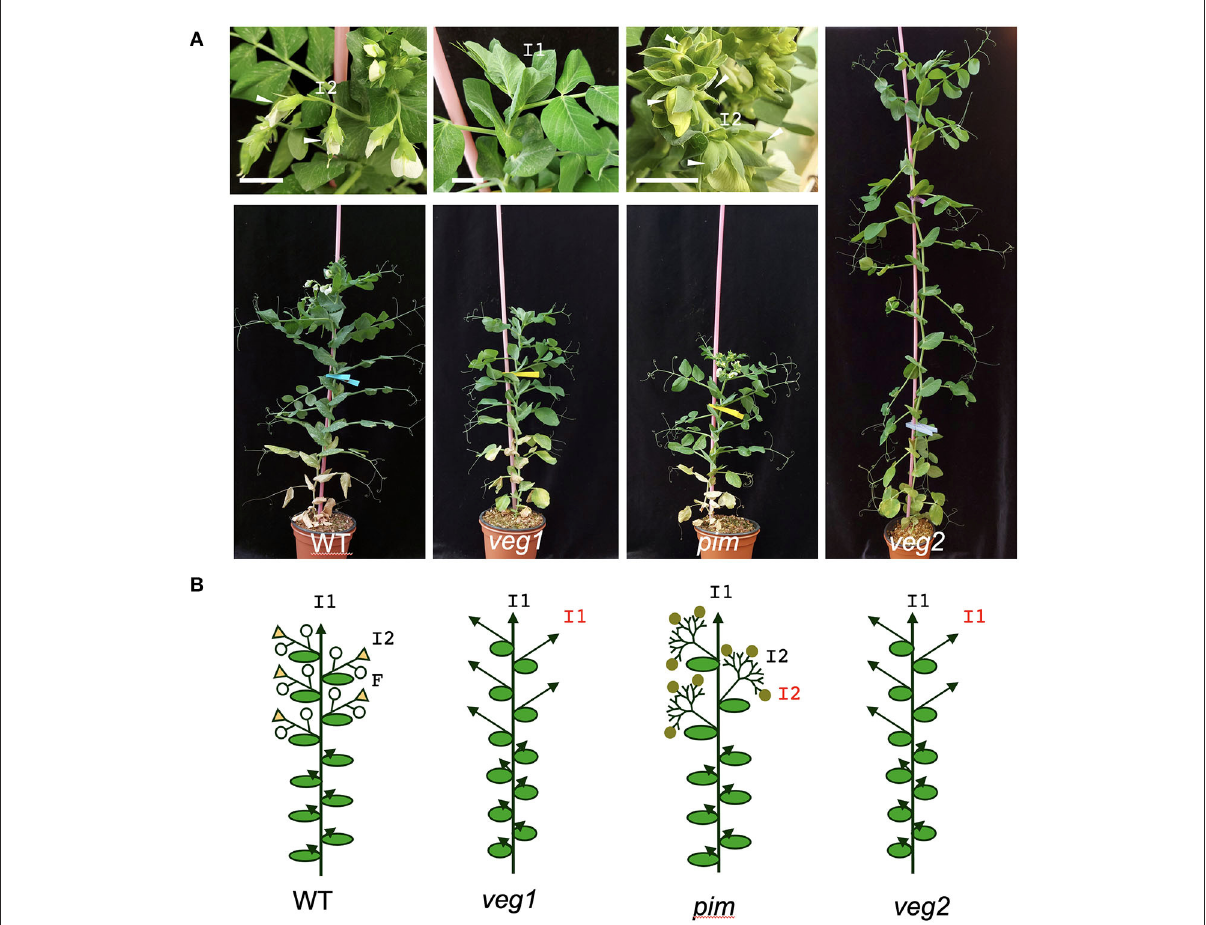
FIGURE1 Inflorescence architecture of wild-type pea and veg1 , pim, and veg2 mutants (A) Images of wild-type (WT), veg1 , pim, and veg2 plants (lower panels). In the close-up pictures of the inflorescences of those plants (upper panels), I1 and I2s are marked. Flowers are marked with arrowheads. The WT usually has two flowers per I2, while in pim more flowers are produced. The veg1 and veg2 mutants neither produce I2s nor flowers. (B) Diagrams showing the inflorescence architecture of these genotypes. F, flower; white circles represent WT flowers; brown circles represent abnormal pim flowers; yellow triangles represent the stubs; scale bars: 2cm. The diagrams of the pea plants in (B) are much based on those published previously by us in this journal (Benlloch et al., 2015), with minor modifications.